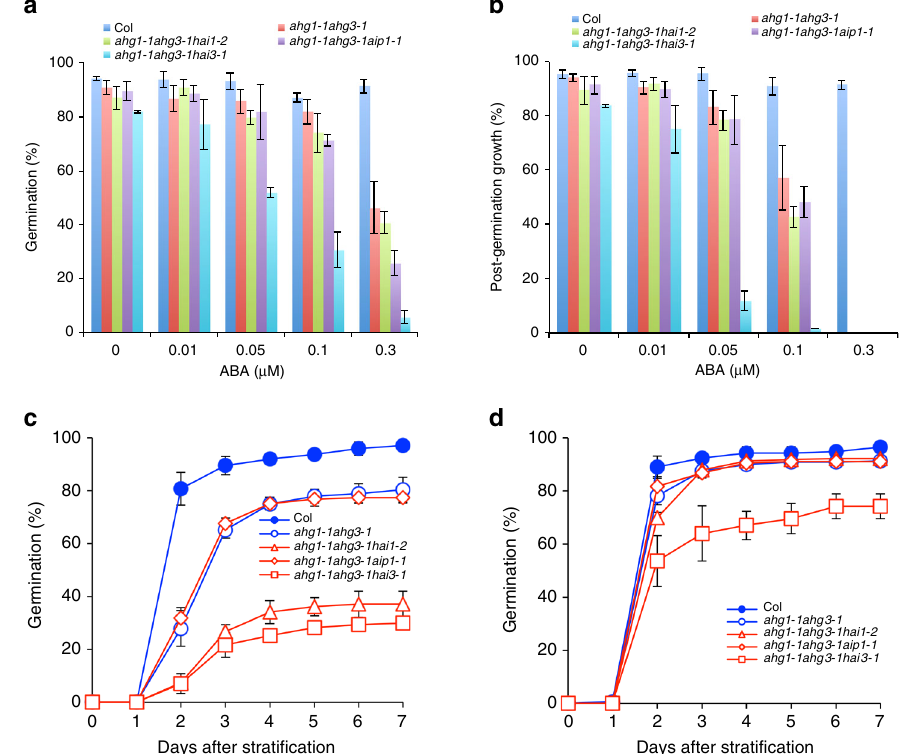
Fig. 2 The triple mutants of PP2C show ABA hypersensitivity. a , b Germination ef fi ciencies ( a ) and post-germination growth ef fi ciencies ( b ) of pp2c double and triple mutant lines ( ahg1-1ahg3-1 , ahg1-1ahg3-1hai1-2 , ahg1-1ahg3-1aip1-1 , and ahg1-1ahg3-1hai3-1 ), and wild-type were examined in the presence of various concentrations of ABA at 3 days ( a ) and 7 days ( b ) after strati fi cation. c , d Germination ef fi ciencies of pp2c double and triple mutant lines and wild- type were examined with strati fi cation for 0 days ( c ) or 4 days ( d ). Error bars show s.d. of three independent experiments using the same seed batch ( a – d )